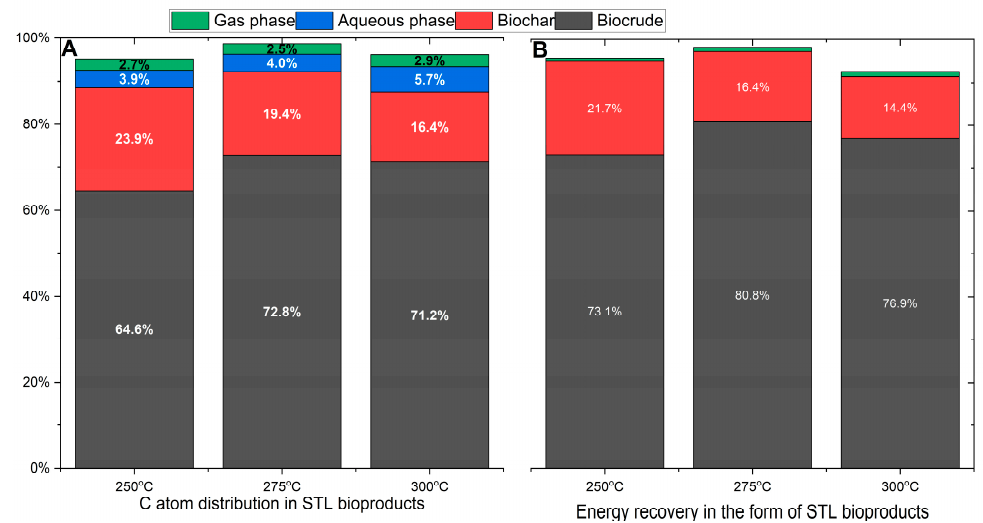
Figure 5. Distribution of C atom ( A ) and energy recovery ( B ) in the bioproducts of solvothermal liquefaction (STL) of blackcurrant pomace.